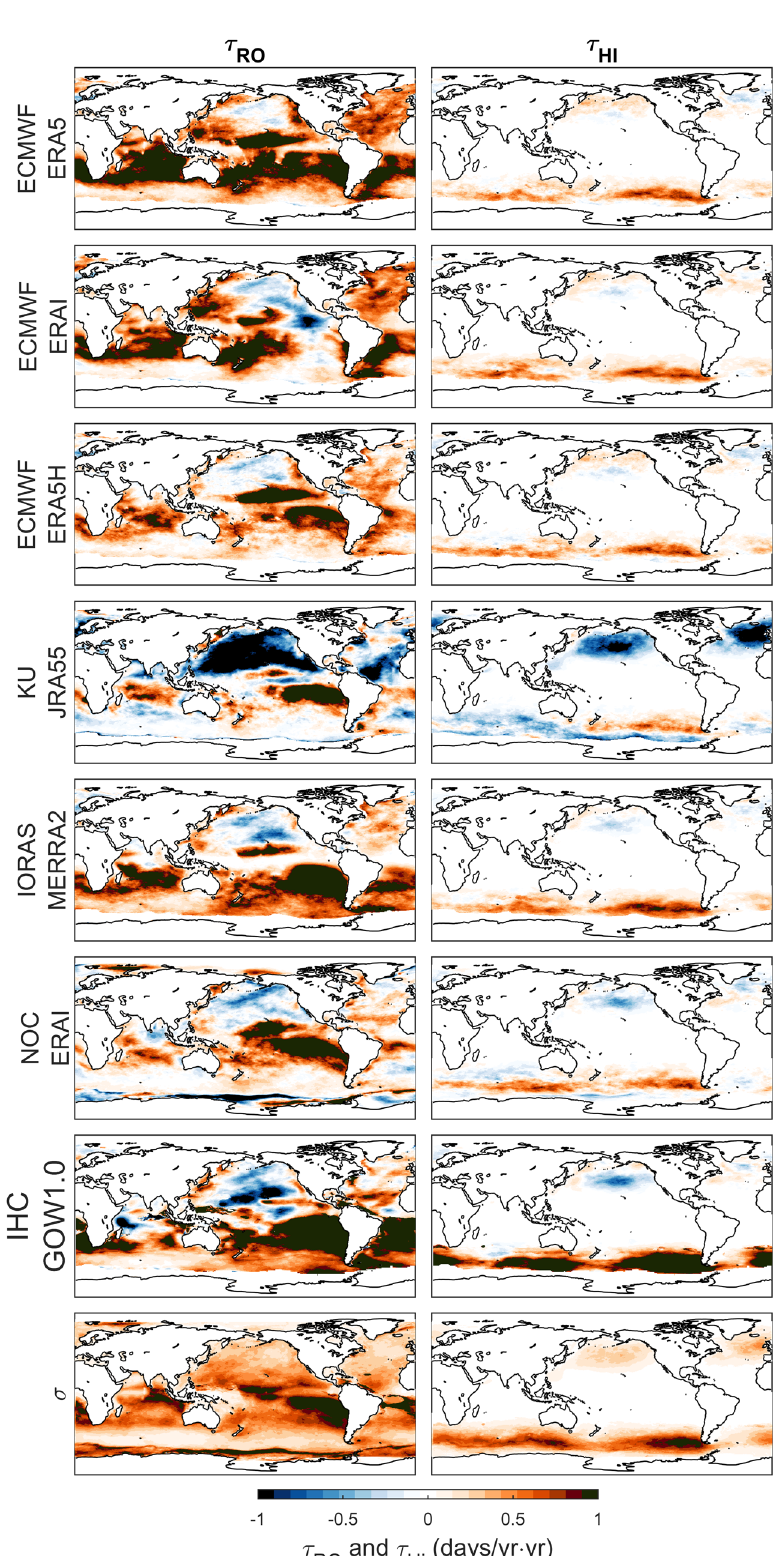
Fig. 3 Trends in the frequency of high wave events. Trends in an annual number of rough ( τ RO ) and high wave days ( τ HI ) for each individual reanalysis and hindcast products used within the 7-member ensemble for 1980 –